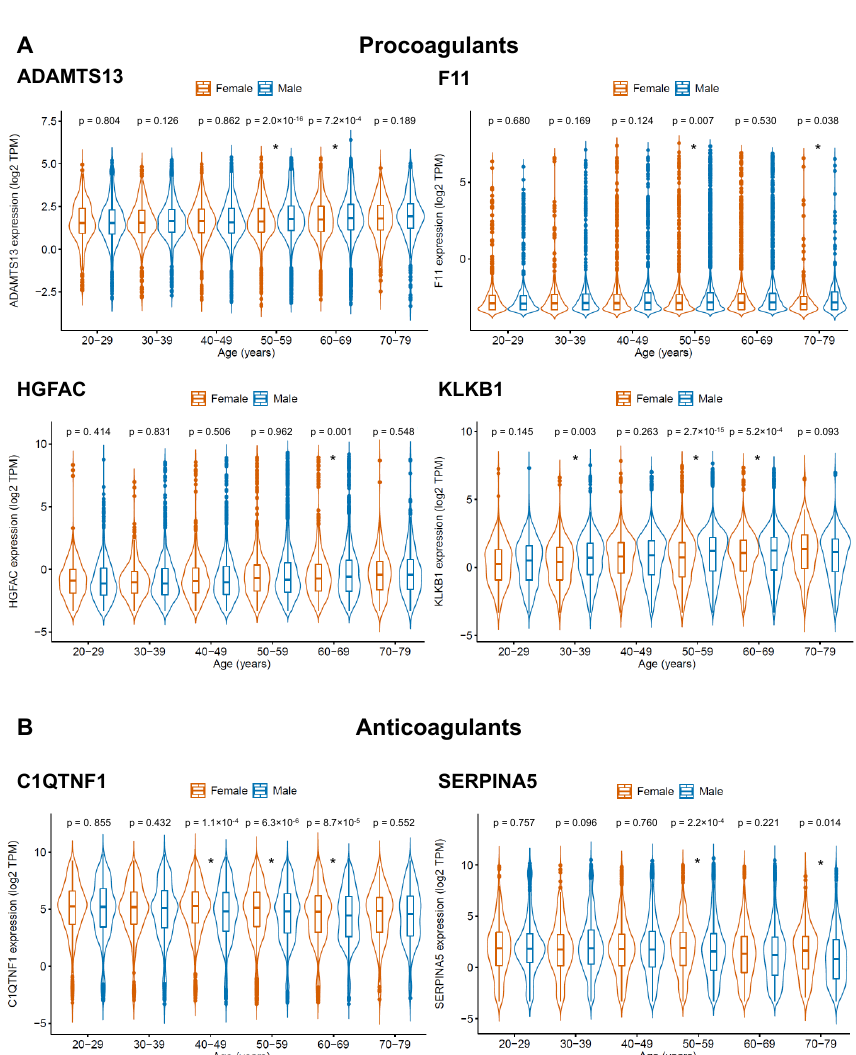
Figure 1. Gene products anticipated to be of potential relevance for COVID-19-related coagulopathy, based on genes with a role in coagulation that are differentially expressed between females and males (Table S1) and whose expression correlates with age (Table S2). Candidate gene products were either ( A ) procoagulants (ADAMTS13, F11, HGFAC, KLKB1), which display higher expression in males than in females and increase with age, or ( B ) anticoagulants (C1QTNF1, SERPINA5), which display higher expression in females than in males and decrease with age. A complete list of the relevant genes overlapping between Table S1 and Table S2 is presented in Table S3. p -values were determined by two-sided Student’s t -test. * p -value < 0.05.